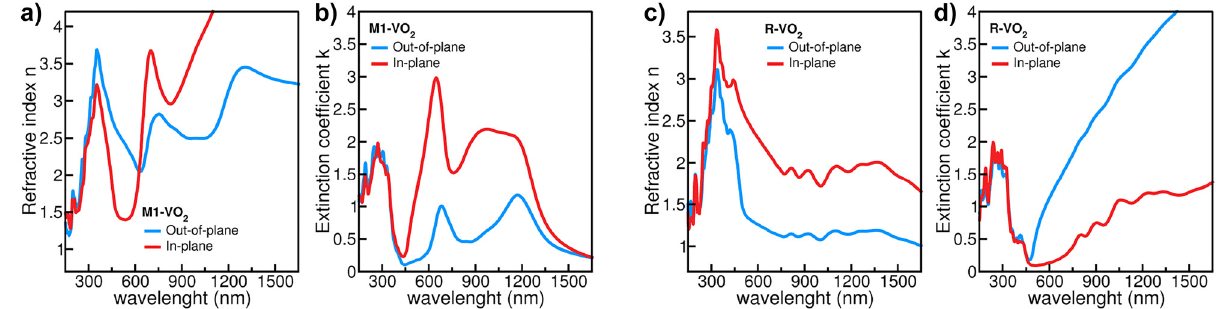
Figure 4: Simulated refractive index n (a and c) and extinction coefficient k (b and d) along the out-of-plane (blue line) and in-plane (red line) crystalline bulk in the monoclinic (M1) and rutile (R) phase, as a function of the wavelength of incoming directions for VO 2